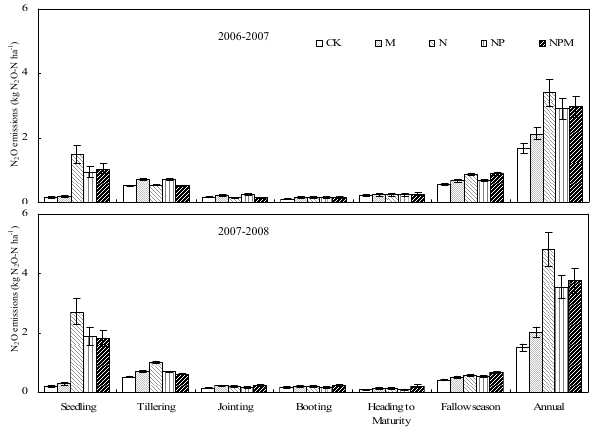
Fig. 3. Changes in N 2 O emissions with winter wheat growth for dif- ferent fertilization treatments from September 2006 until September 2008.